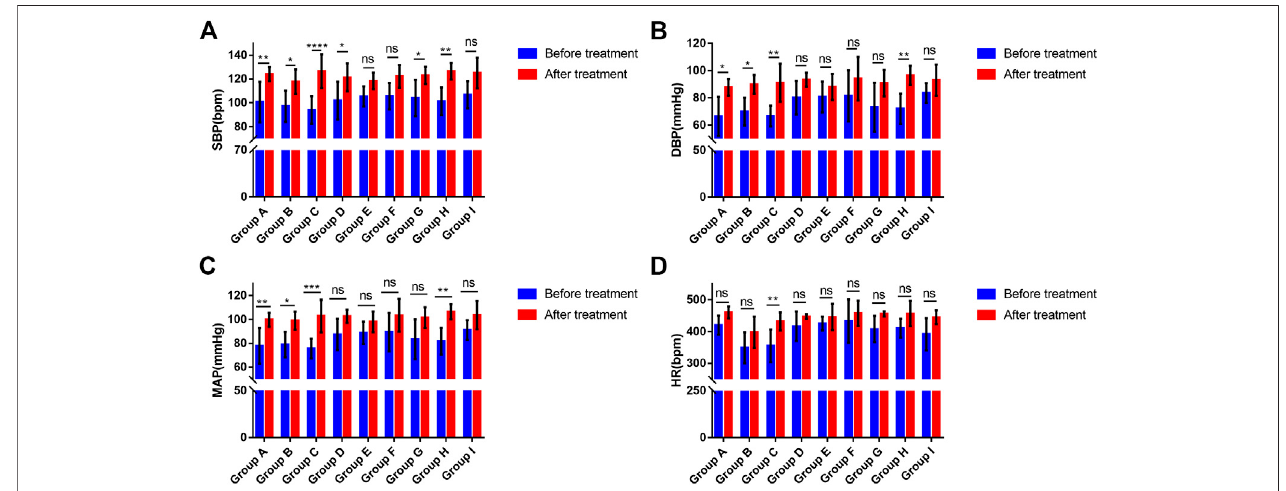
FIGURE 2 | Changes in the blood pressure and heart rate of rats (A) . Changes in SBP associated with phenylephrine eye drops and (or) intravenous atropine treatment; (B) . Changes in DBP associated with phenylephrine eye drops and (or) intravenous atropine treatment; (C) . Changes in MAP associated with phenylephrine eye drops and (or) intravenous atropine treatment; (D) . Changes in HR associated with phenylephrine eye drops and (or) intravenous atropine treatment. Error bars represent the mean ± SD. SBP, systolic blood pressure; DBP, diastolic blood pressure; MAP, mean arterial pressure; HR, heart rate. Before treatment, blood pressure and heart rate before the administration of phenylephrine and (or) atropine. After treatment, the highest blood pressure and heart rate during the observation period. Group A received phenylephrine eye drops. Group B received intravenous atropine treatment. Group C received phenylephrine and atropine simultaneously. Groups D, E, and F received phenylephrine eye drops fi rst and then intravenous atropine treatment fi ve, ten, and 15 min later, respectively. Groups G, H, and I received intravenous atropine treatment fi rst followed by phenylephrine eye drops fi ve, ten, and 15 min later, respectively. N (cid:1) six.